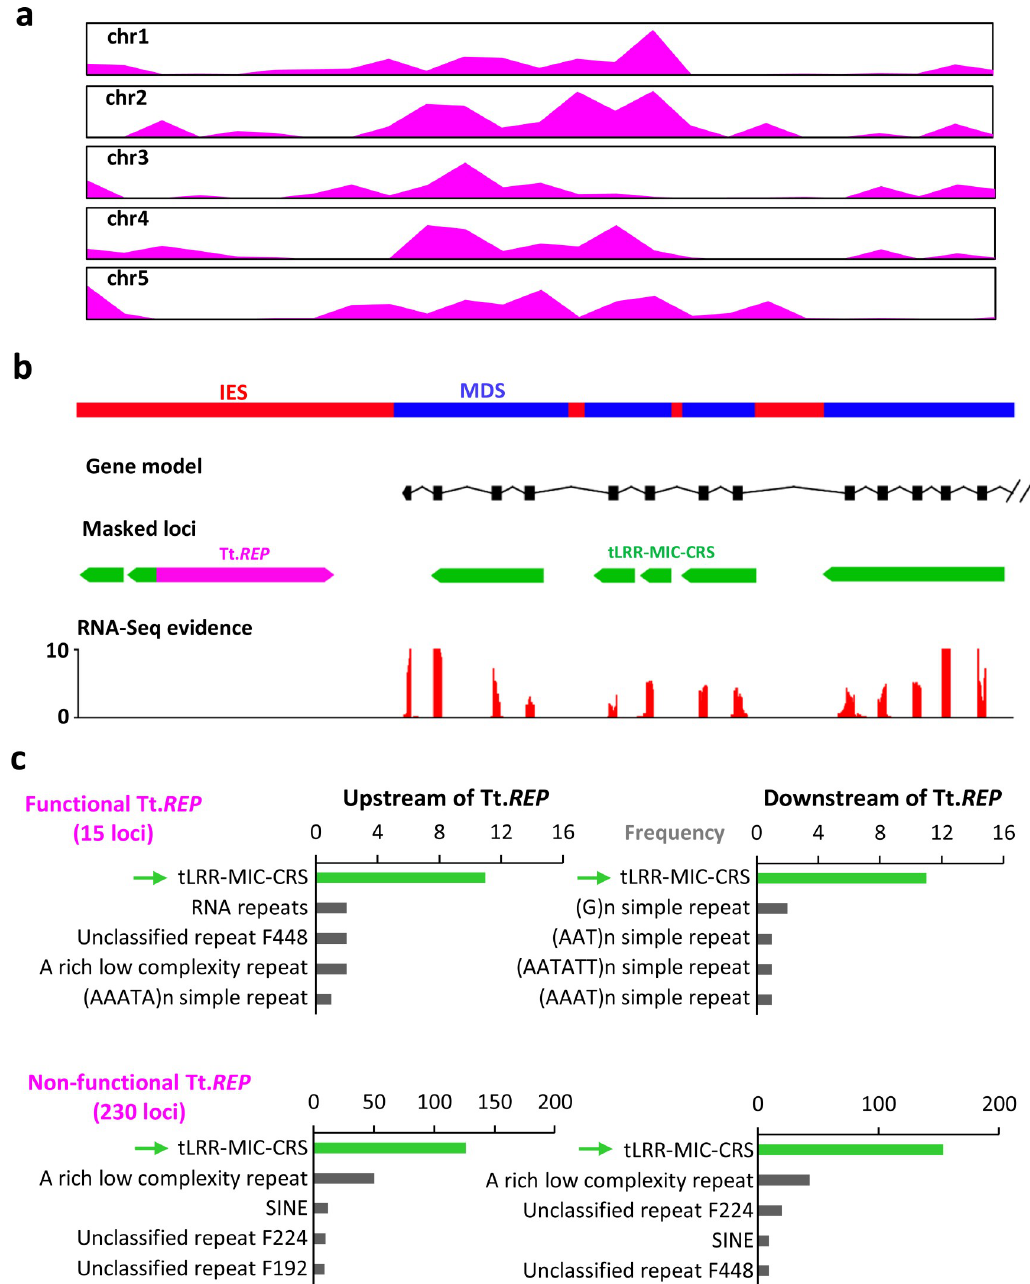
Fig 8. Group III LRR gene repeats are the most common element flanking non-LTR REP retrotransposons in the T . thermophila MIC genome. (a) Tt. REP sequence distribution across 5 MIC chromosomes in T . thermophila , normalized to the same length. (b) Example of a Tt. REP (non-LTR REP retrotransposon in T . thermophila ) fragment flanking tLRR-MIC-CRS– masked segments of a functional group III LRR gene (TTHERM_01344670), containing a 90-bp exon array and supported by RNA-Seq gene expression data. (c) MIC sequences masked by tLRR-MIC-CRS are most frequently flanked on one or both sides by Tt. REP . Green bar and arrow, tLRR-MIC-CRS–masked loci; black bars, loci masked by the next most frequent repeat families or low-complexity sequences. Numerical data underlying this panel are listed in S2 Data. chr1, Chromosome 1; CRS, consensus repeat sequence; IES, internal eliminated sequence; LRR, leucine-rich repeat; MAC, macronucleus; MDS, MAC-destined sequence; MIC, micronucleus; non-LTR, Non-long terminal repeat; RNA-Seq, RNA sequencing; Tt. REP , T . thermophila REP